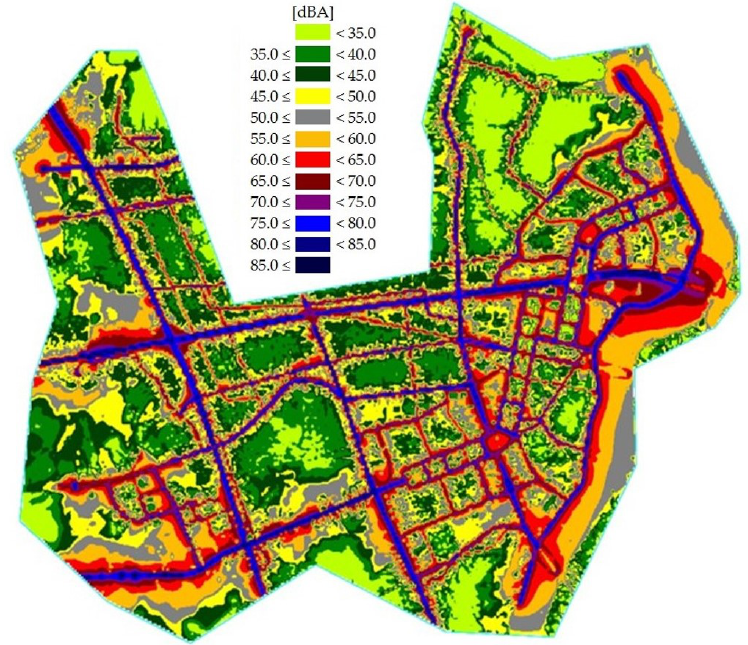
Figure 5. Road traffic noise map of the research area.